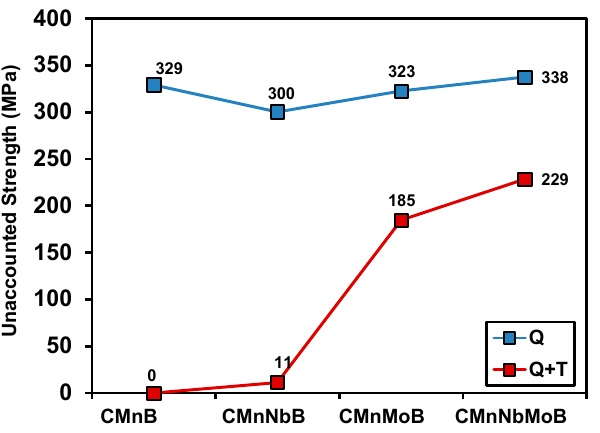
Figure 13. Contribution of unaccounted strength to the yield strength for both Q and Q + T condi- tions.